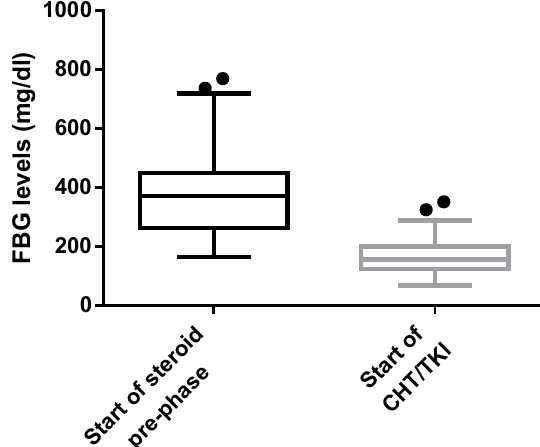
Figure 1. Whiskers plot representation of overall drop of FBG levels in the 74 patients who experienced HF; the two boxes refer to two timepoints: at the start of steroid prephase and at the start of CHT/TKI. The dots outside the whiskers represent the outliers. The difference between the two groups using Mann–Whitney U test is statistically significant ( p < 0.0001). FBG: fibrinogen; HF: